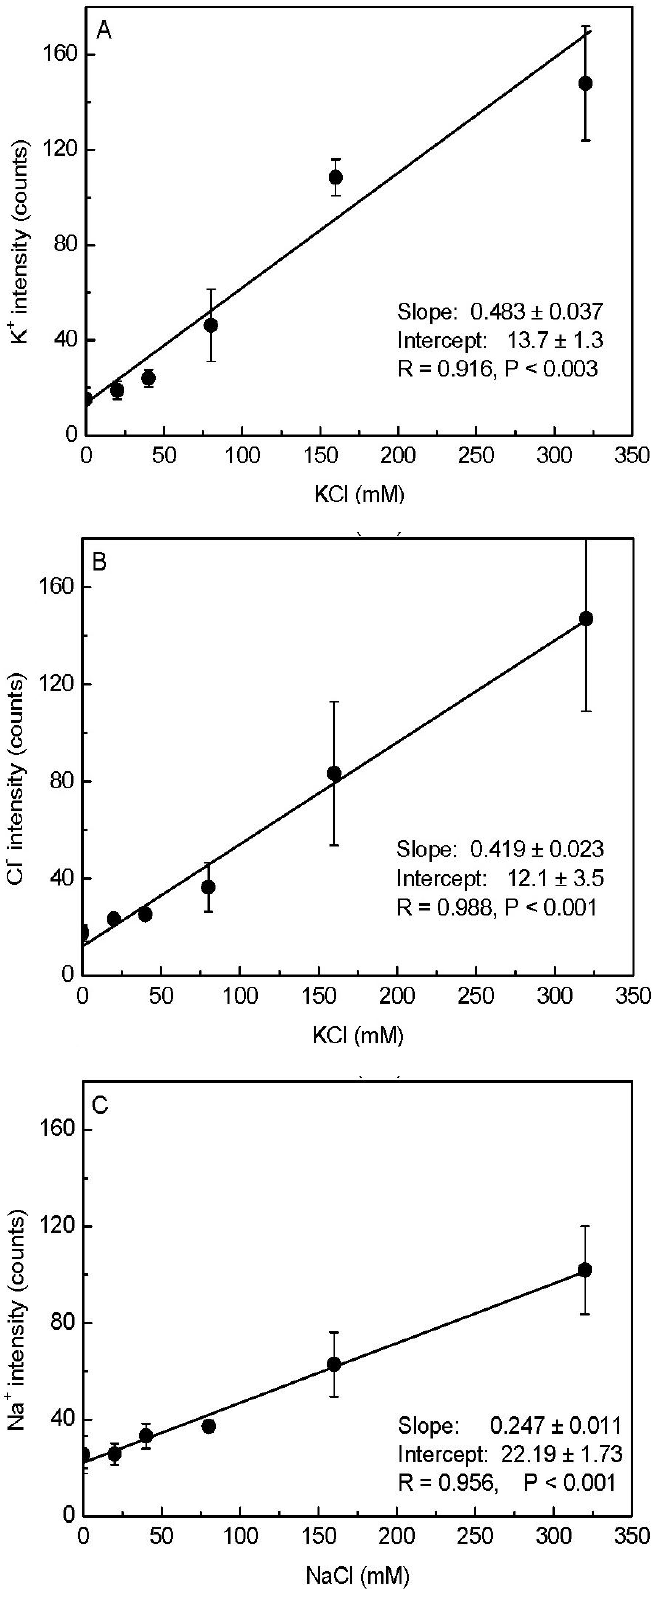
Figure 2. Correlation between pixel intensities calculated from elemental images and the amounts of K + ( A ), Cl − ( B ), and Na + ( C ) present in the agar blocks. Data were fitted by linear regression. Data represent means ± SD ( n =